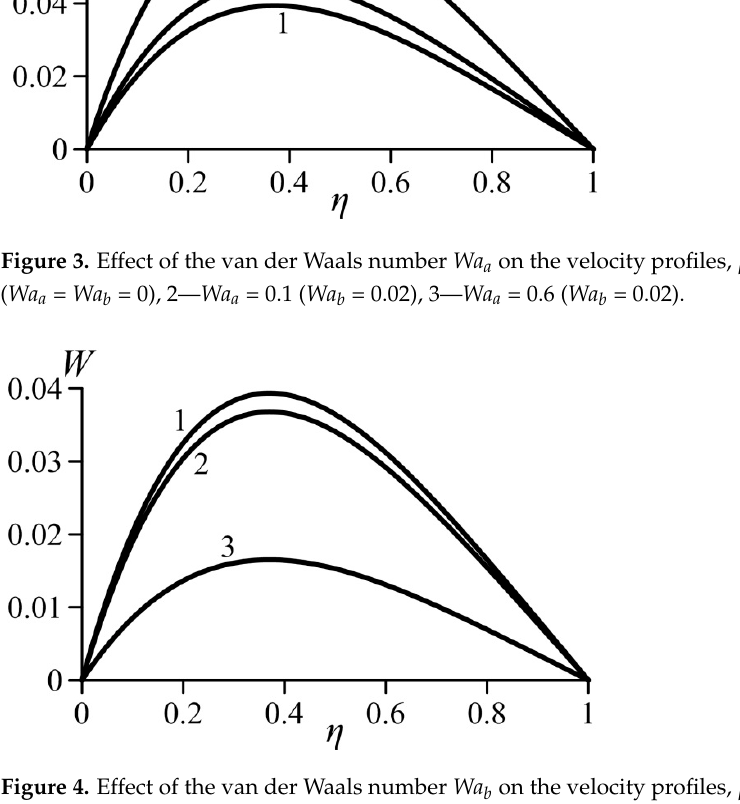
Figure 4. Effect of the van der Waals number Wa b on the velocity profiles, βθ w = 0.01. 1—ideal gas ( Wa a = Wa b = 0), 2— Wa b = 0.1 ( Wa a = 0.02), 3— Wa b = 0.4 ( Wa a = 0.02).